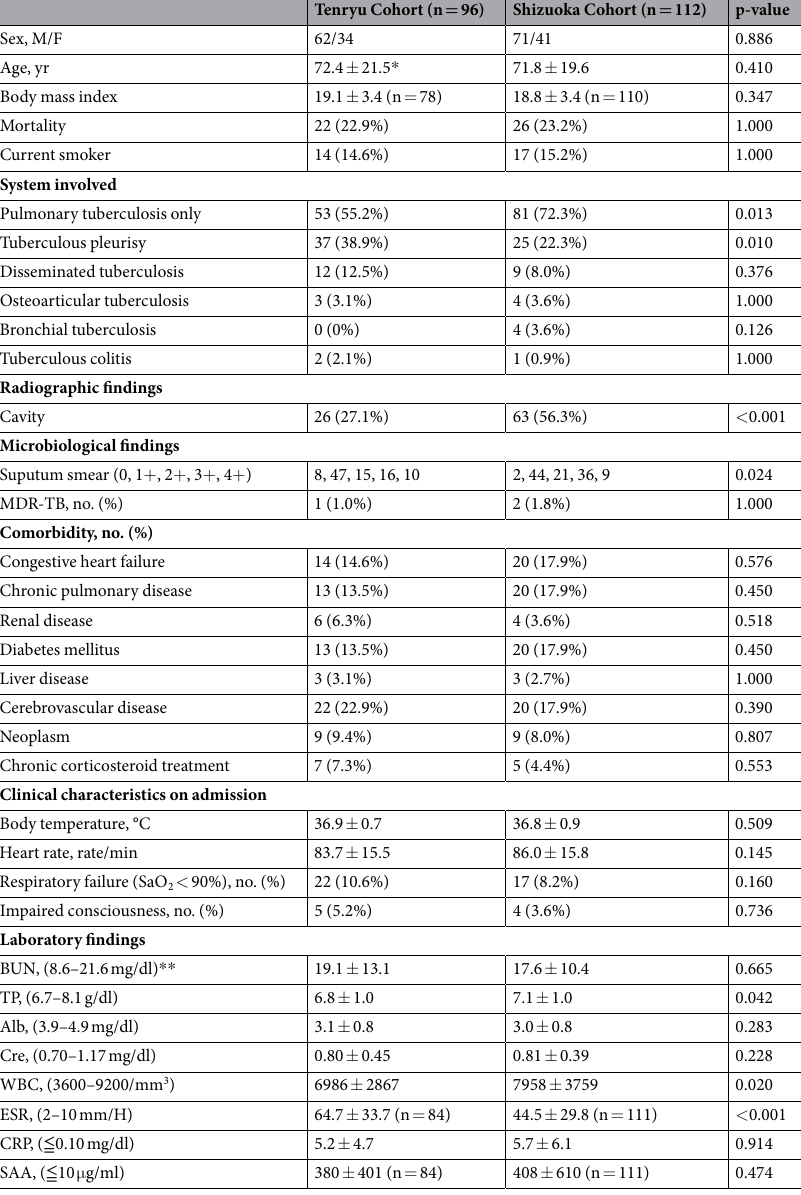
Table 1. Clinical characteristics of patients with pulmonary tuberculosis. MDR-TB, multidrug resistant tuberculosis;